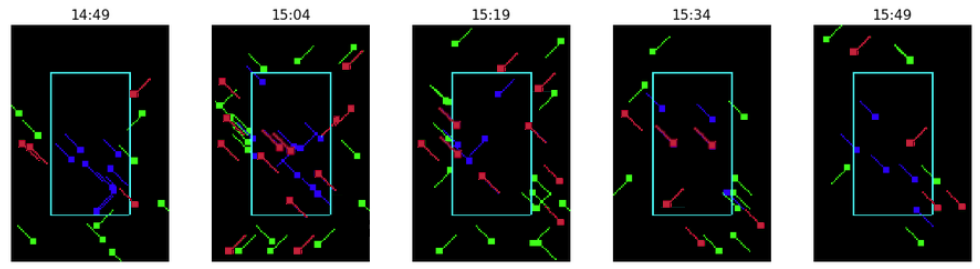
Figure 6. Representation of the RL system outcome for the regulation